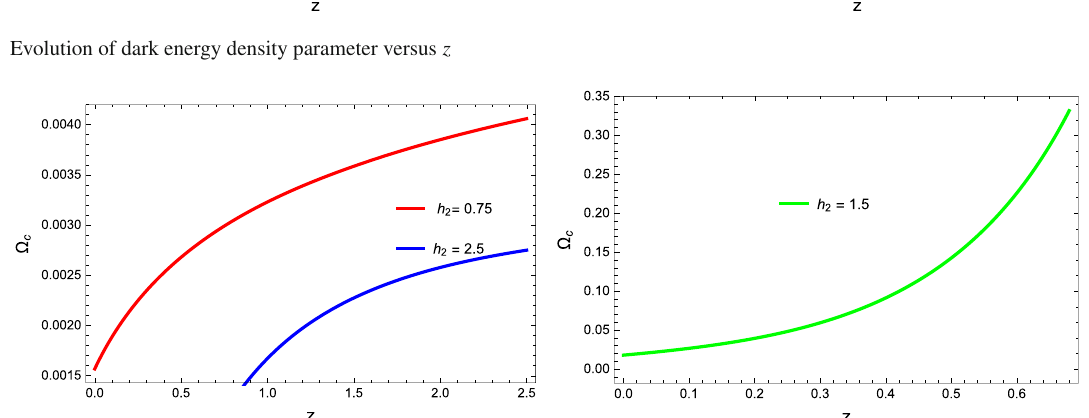
Fig. 16 Evolution of dark energy density parameter versus